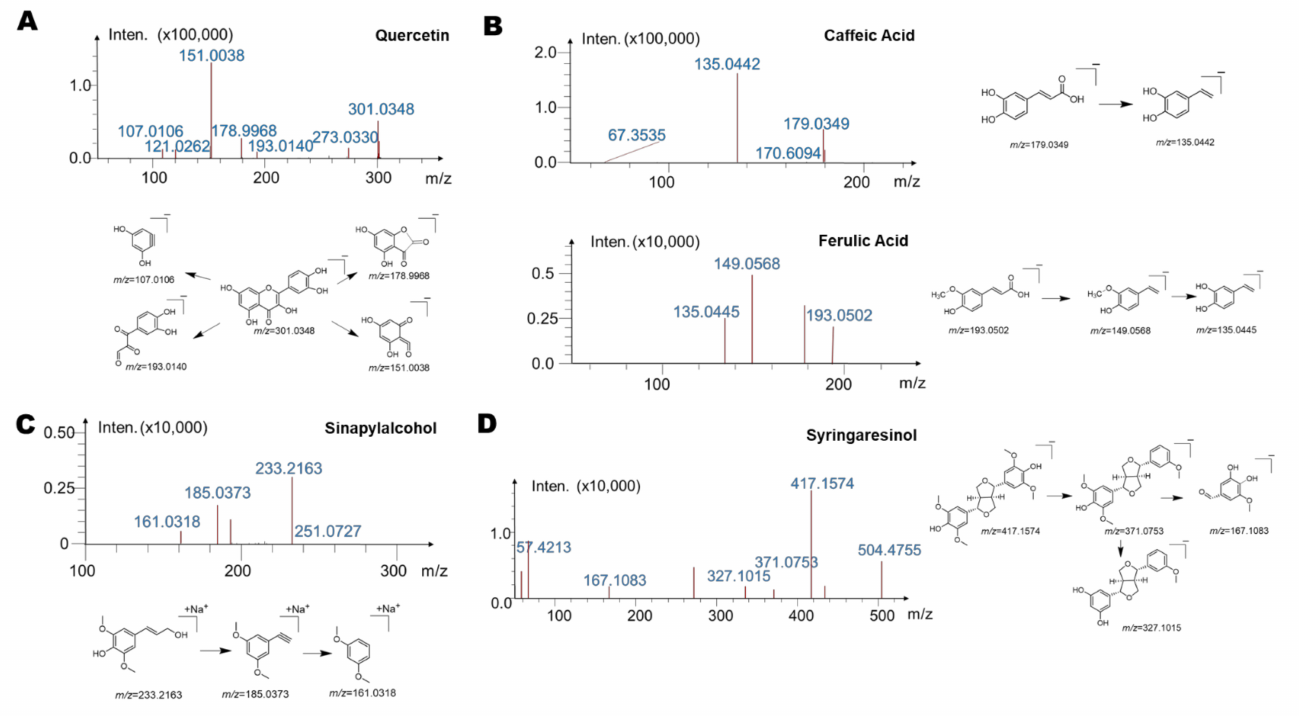
Figure 4. High-resolution mass spectrometry of intestinal bacterial metabolites of four main sub- stances (chlorogenic acid, syringin, acanthoside B, rutin) of Saussurea involucrata . ( A ) The mass spectral cleavage pathway of quercetin (metabolite of rutin). ( B ) The mass spectral cleavage pathway of caffeic acid and ferulic acid (metabolites of chlorogenic acid). ( C ) The mass spectral cleavage pathway of sinapylalcohol (metabolite of syringin). ( D ) The mass spectral cleavage pathway of syringaresinol (metabolite of acanthoside